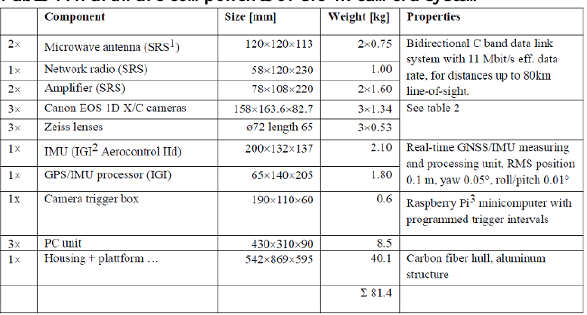
Table 1: Hardware components of the 4k camera system